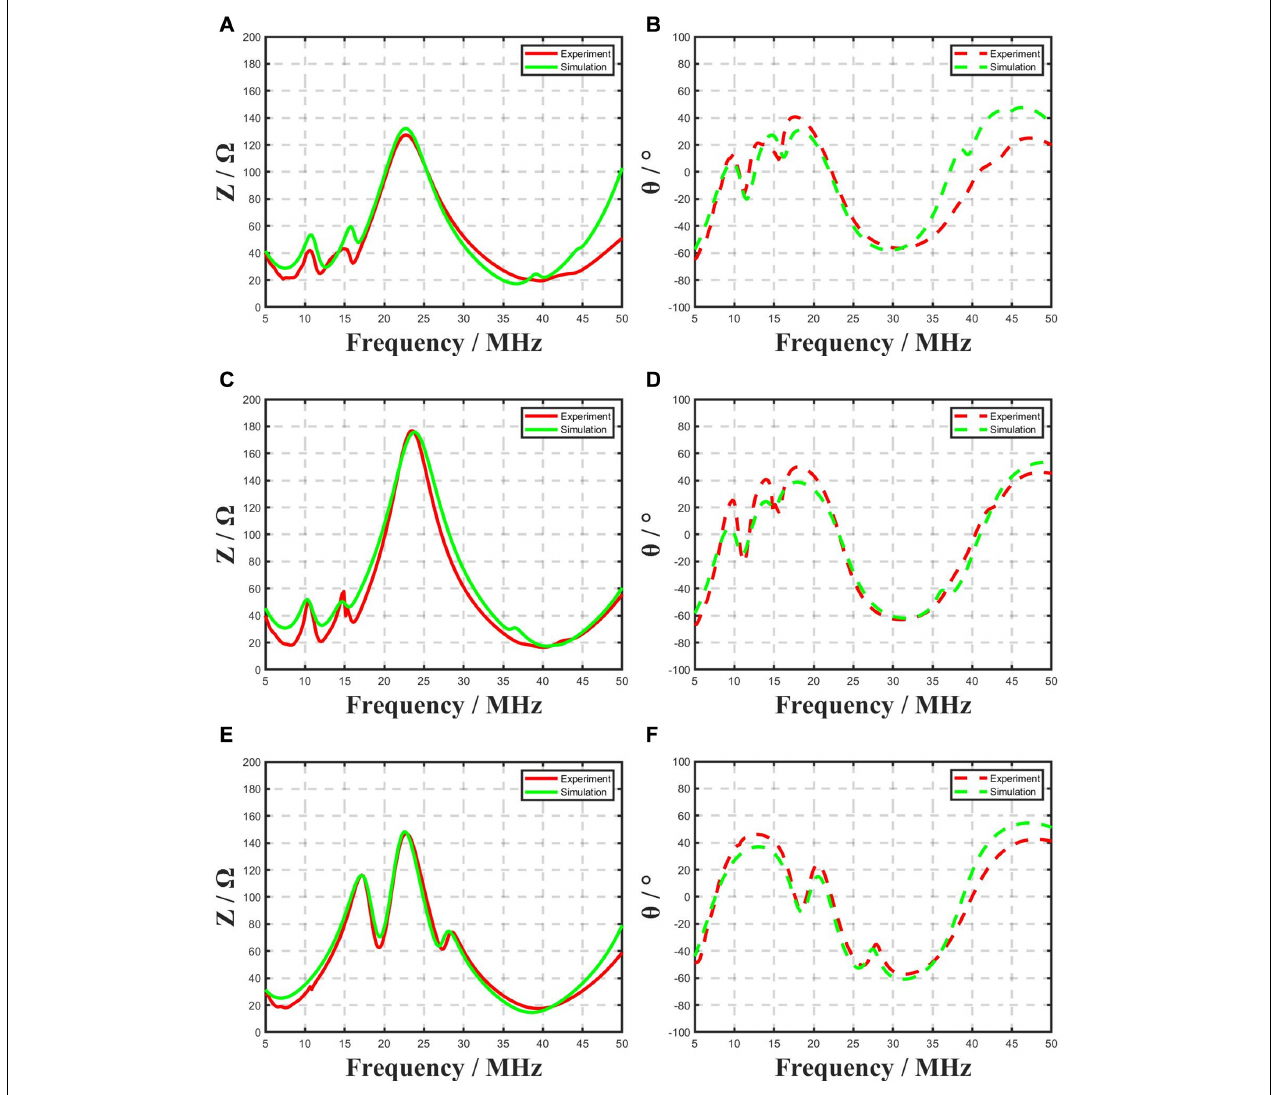
FIGURE 8 | The simulated and measured results of transducer with cable (A) the amplitude of No. 1 transducer (B) the phase of No. 1 transducer (C) the amplitude of No. 2 transducer (D) the phase of No. 2 transducer (E) the amplitude of No. 3 transducer (F) the phase of No. 3